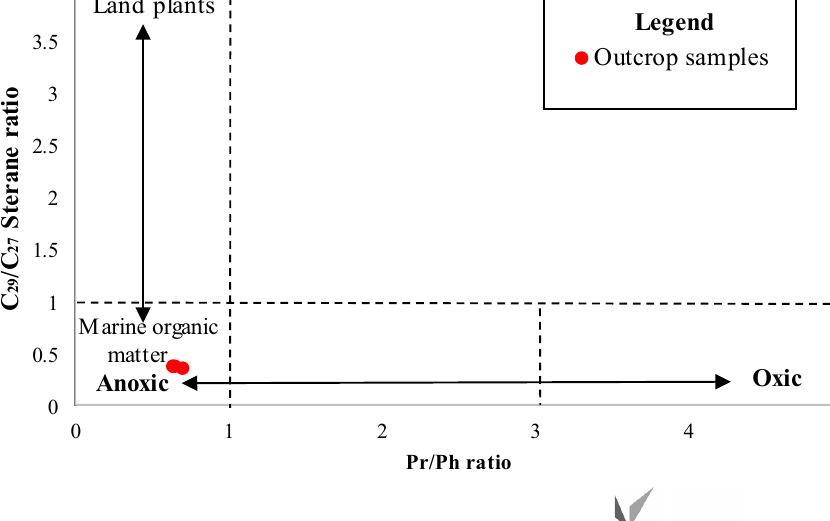
Fig. 11 The Pr/Ph ratio versus C 29 /C 27 steranes ratio cross-plot provides information about the environment of deposition and type of organic input (after Peters et al.